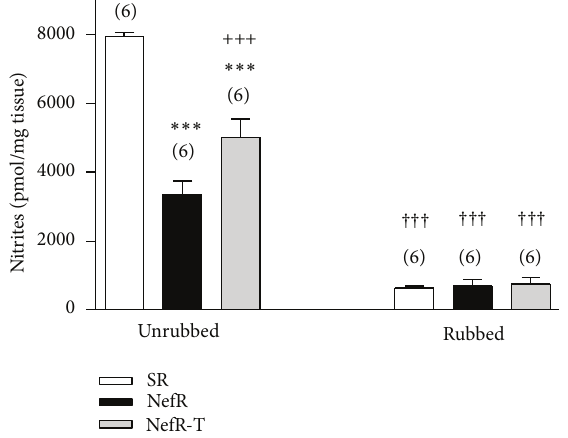
Figure 2: Nitrite contents in aortic rings of SR (white bars), NefR (black bars), and NefR-T (gray bars) with (first group of bars: unrubbed) or without functional endothelium (second group of bars: rubbed) at 15min in the experiment. ∗∗∗ 𝑃 < 0.001 NefR and NefR-T versus SR; +++ 𝑃 < 0.001 NefR-T versus NefR; ††† 𝑃 < 0.001 rubbed versus unrubbed rings. Two way ANOVA. Data are expressed as mean ± standard error. The number of rings is given in